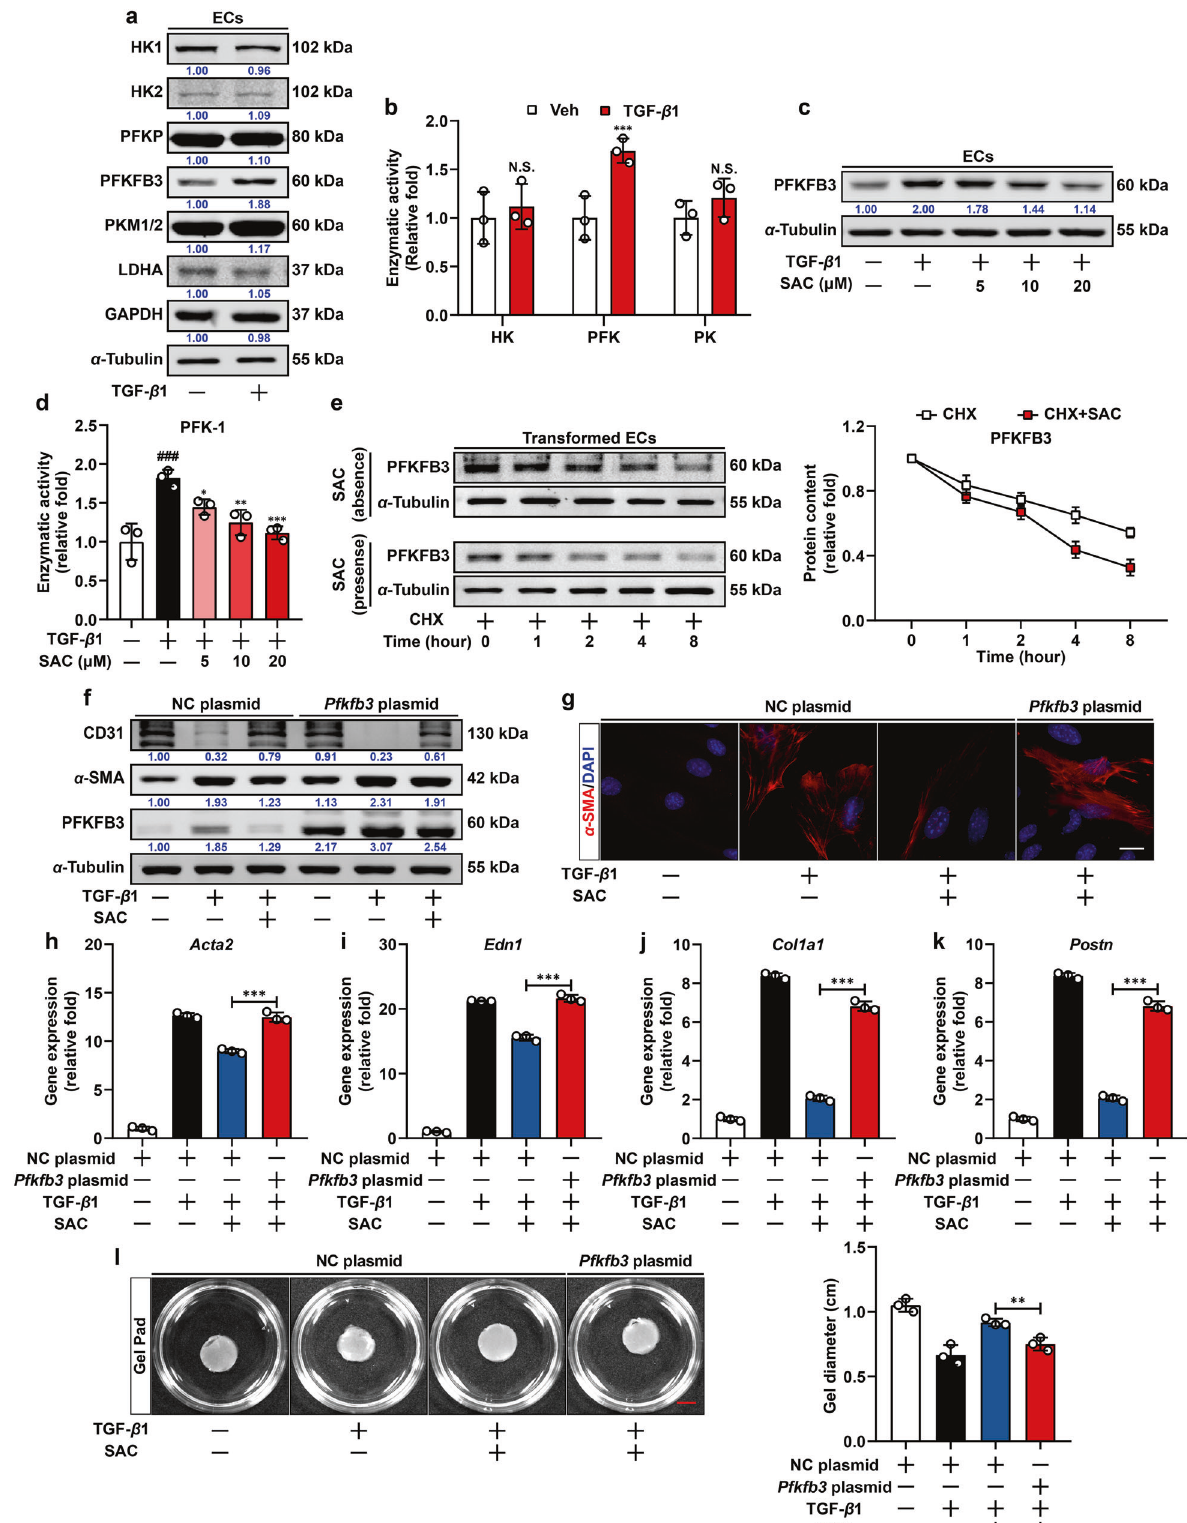
Immunoblot analysis revealed signi fi cant reduction in Fe-S cluster protein levels of ACO2, NDUFS1, and NFS1 in ECs post-TGF- β 1 stimulation, and these alterations were restored by SAC treatment (Fig. 5f).